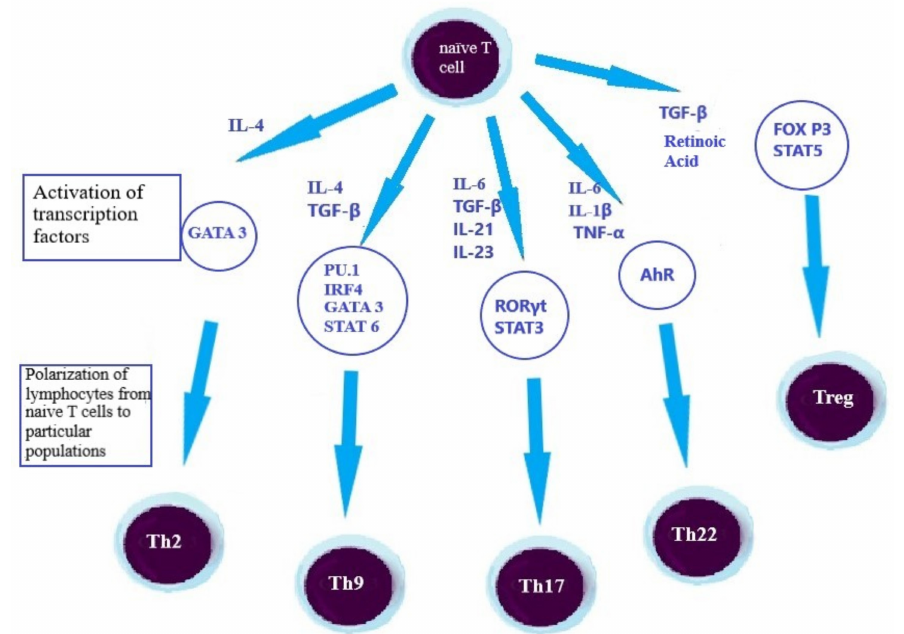
Figure 2. Differentiation of T cells’ main population from the naïve T cells [5,9,25]. AhR—aryl hydrocarbon receptor, FOX P3—forkhead box P3, GATA 3—GATA binding protein 3,